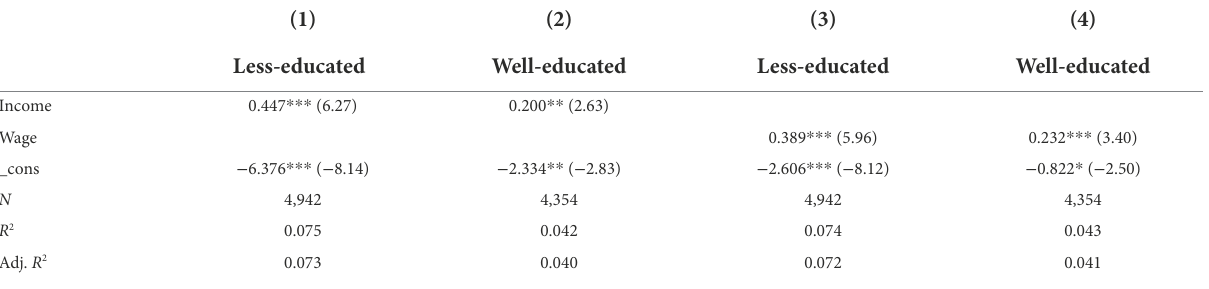
TABLE 6 Heterogeneous effects of different education levels on